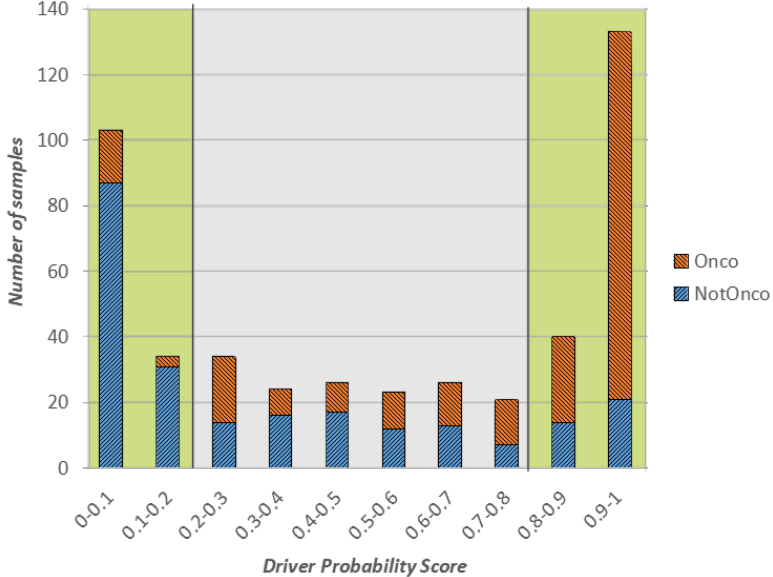
Figure 1. Classification outcome on the test set: class label vs. oncogenic probability